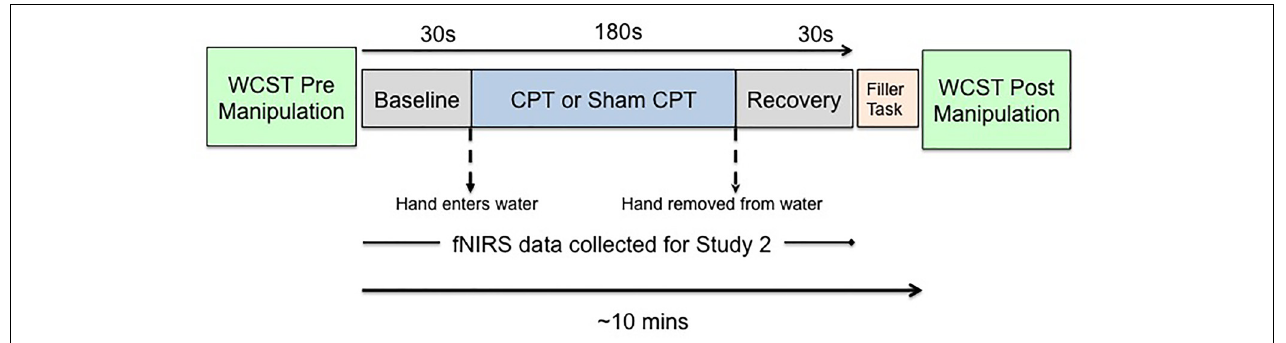
FIGURE 1 | Schematic of the experimental